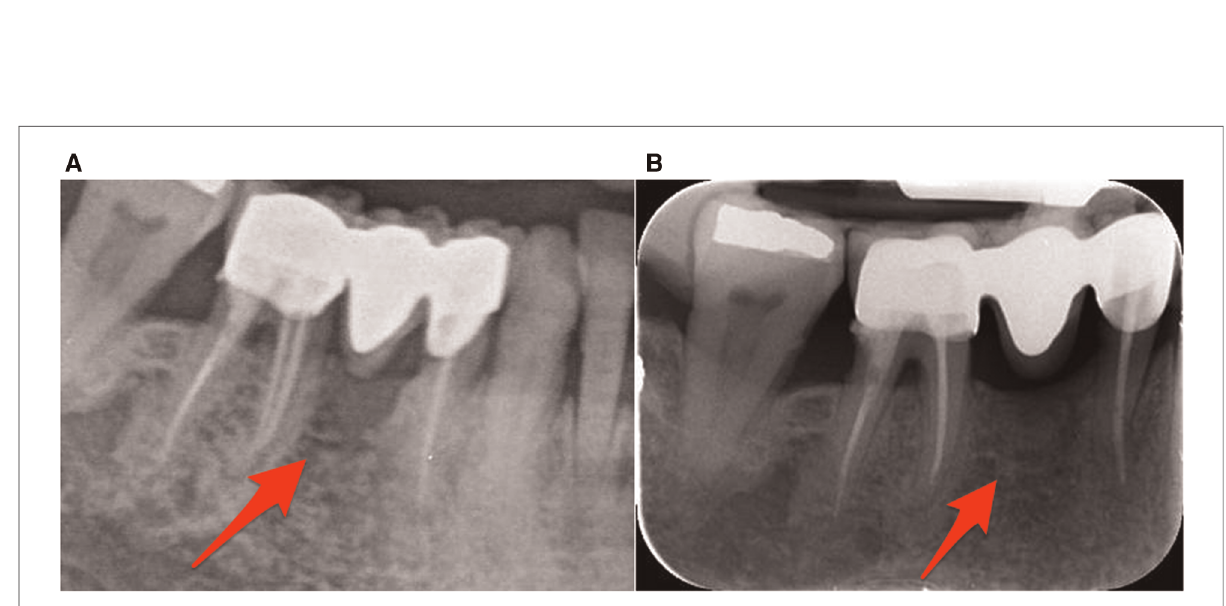
FIGURE 1 Treatment protocol for case 1. ( A ) Panoramic Radiographic Image. A non-healing wound present in tooth site #45, while the lower left 3rd molar area had healed properly. ( B ) The non-healing site during operation. ( C,D ) Intraoral PBMT protocol with 660 nm and 810 nm probes.